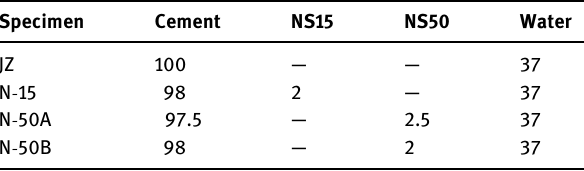
Table 1: Technical speci fi cations of NS Table 2: Mix proportion of specimens ( wt% ) Specimen